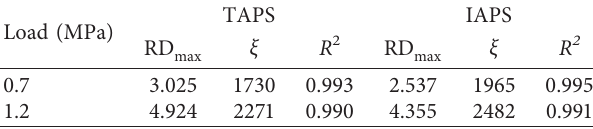
Table 11: Coefficients of the rutting prediction equation.